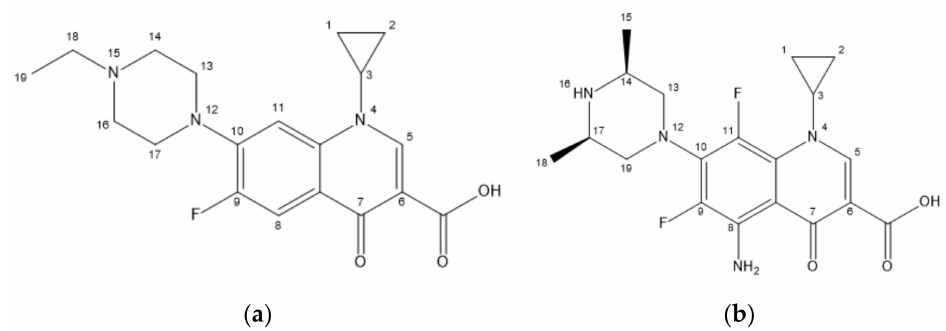
Figure 2. Target molecules ( a ) ENR (enrofloxacin) and ( b ) SPA